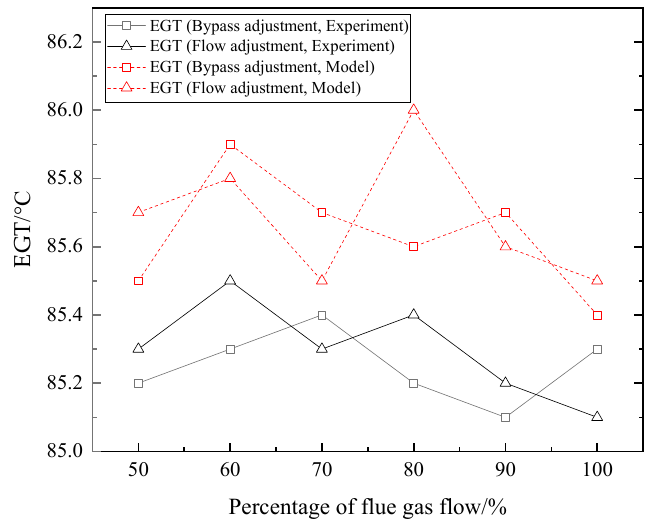
Figure 11. EGT as flue gas flow changed.